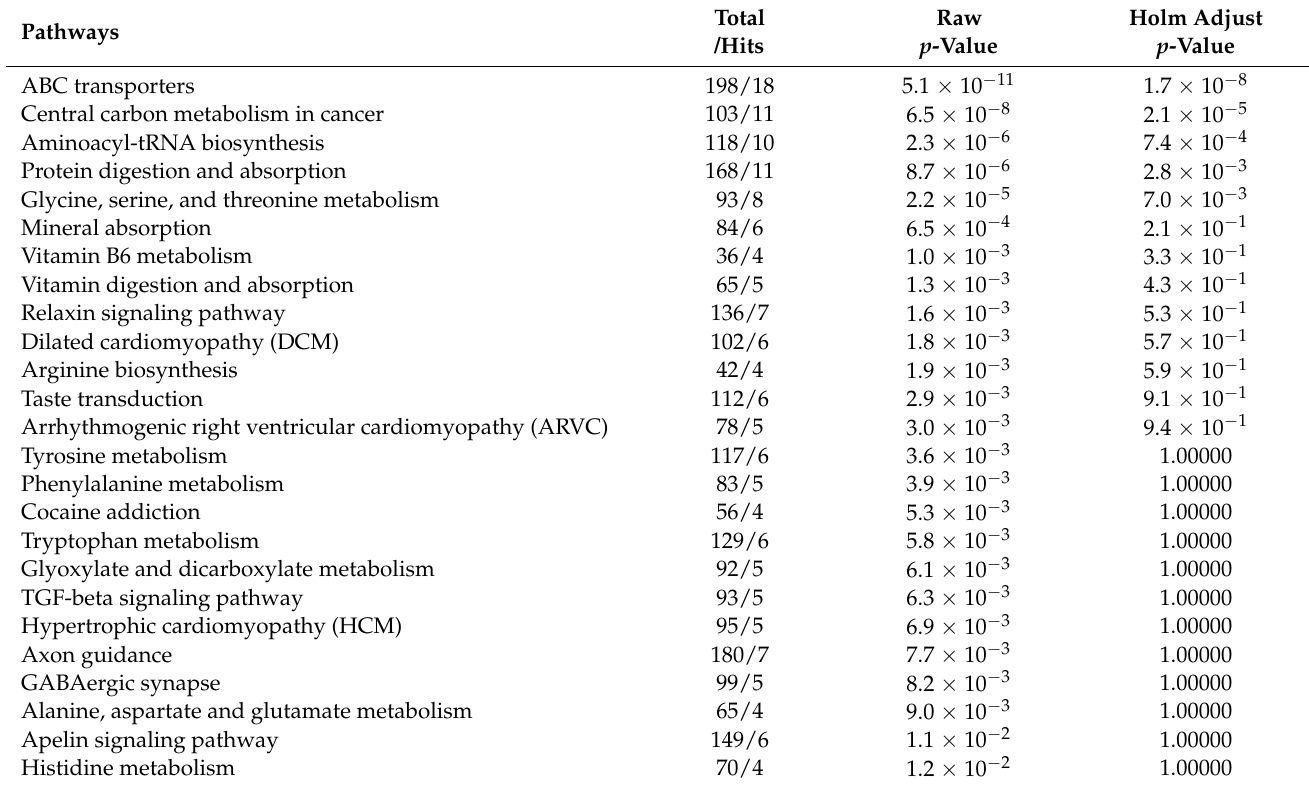
Figure 4. A dot plot illustration of pathway enrichment in the integrated analysis of significantly differentially expressed genes and important metabolites from transcriptome and metabolome data, respectively. Various pathways in the upper and left quadrants are labeled. The dot sizes increase with the increasing pathway impact; the color intensifies according to the y -axis. Statistical summary results of the top enriched pathway of the integrated analysis are detailed in Table 1; the detailed results of all enriched pathways along with the list of enriched genes and metabolites in each of these pathways are listed in Supplementary Table S4. Table 1. Statistical summary of the top 25 metabolic and cellular pathways found in the integrated joint pathway analysis of significantly differentially expressed genes and important metabolites found in heat-stressed granulosa cells.